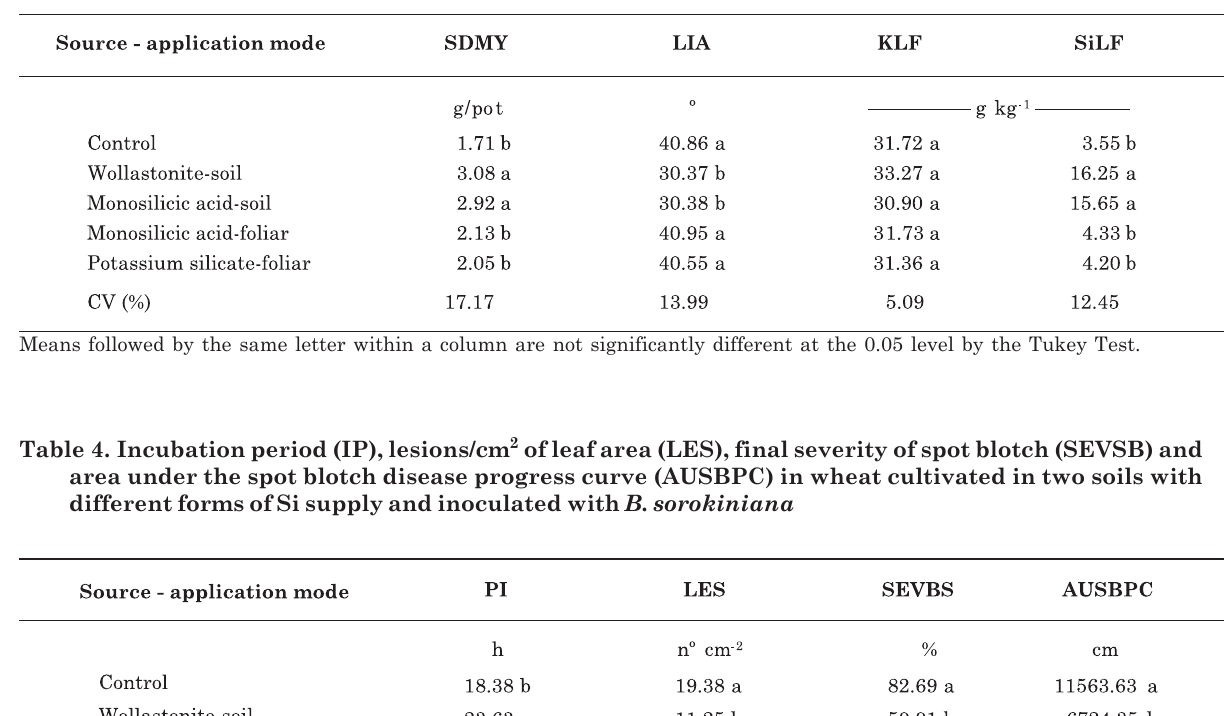
Table 3. Shoot dry matter yield (SDMY), leaf insertion angle (LIA), K leaf content (KLF) and Si leaf content (SiLF) in wheat leaves growing under different forms of Si supply and inoculation with B. sorokiniana